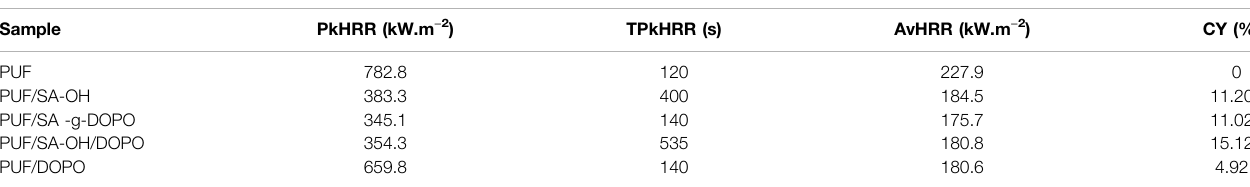
TABLE 3 | CCT results of PUF composites. Sample